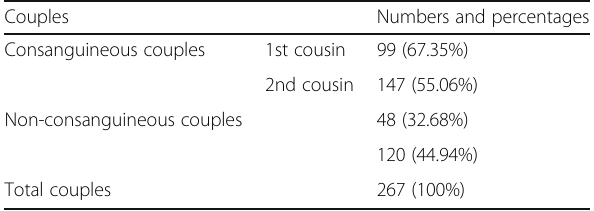
Table 2 Frequency distribution of consanguinity over